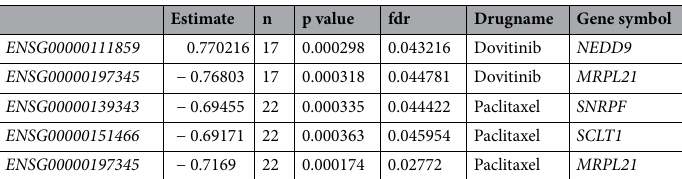
Table 10. Potential genes involved in LUSC drug